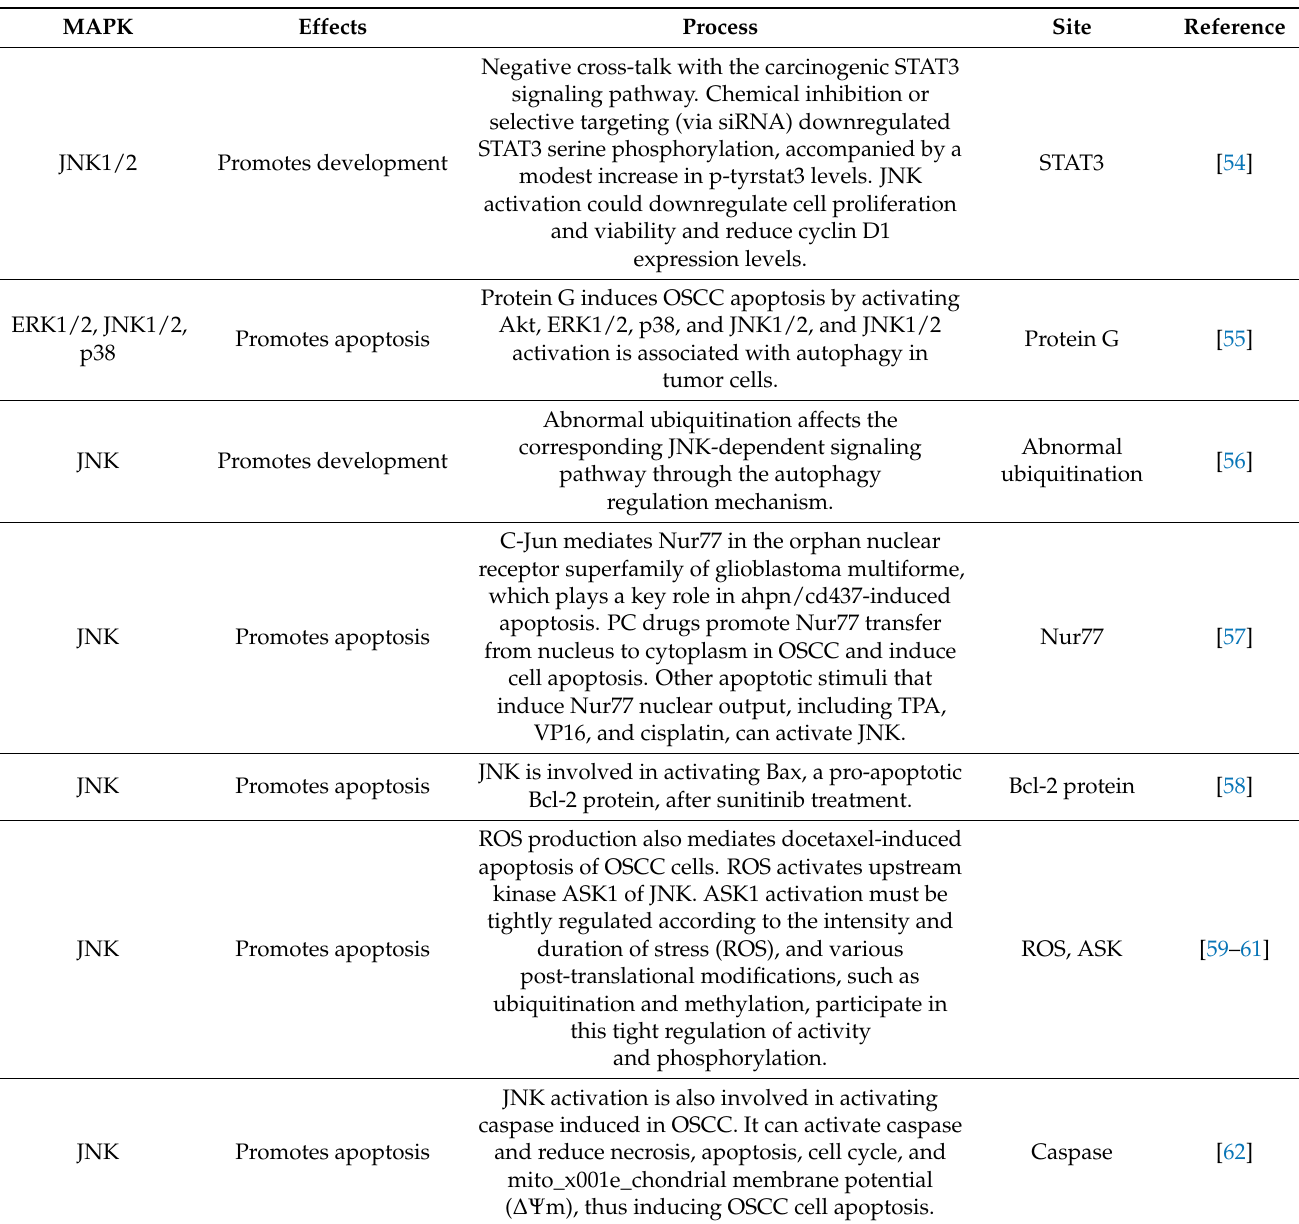
Table 1. Advances in the JNK/MAPK signaling pathway associated with